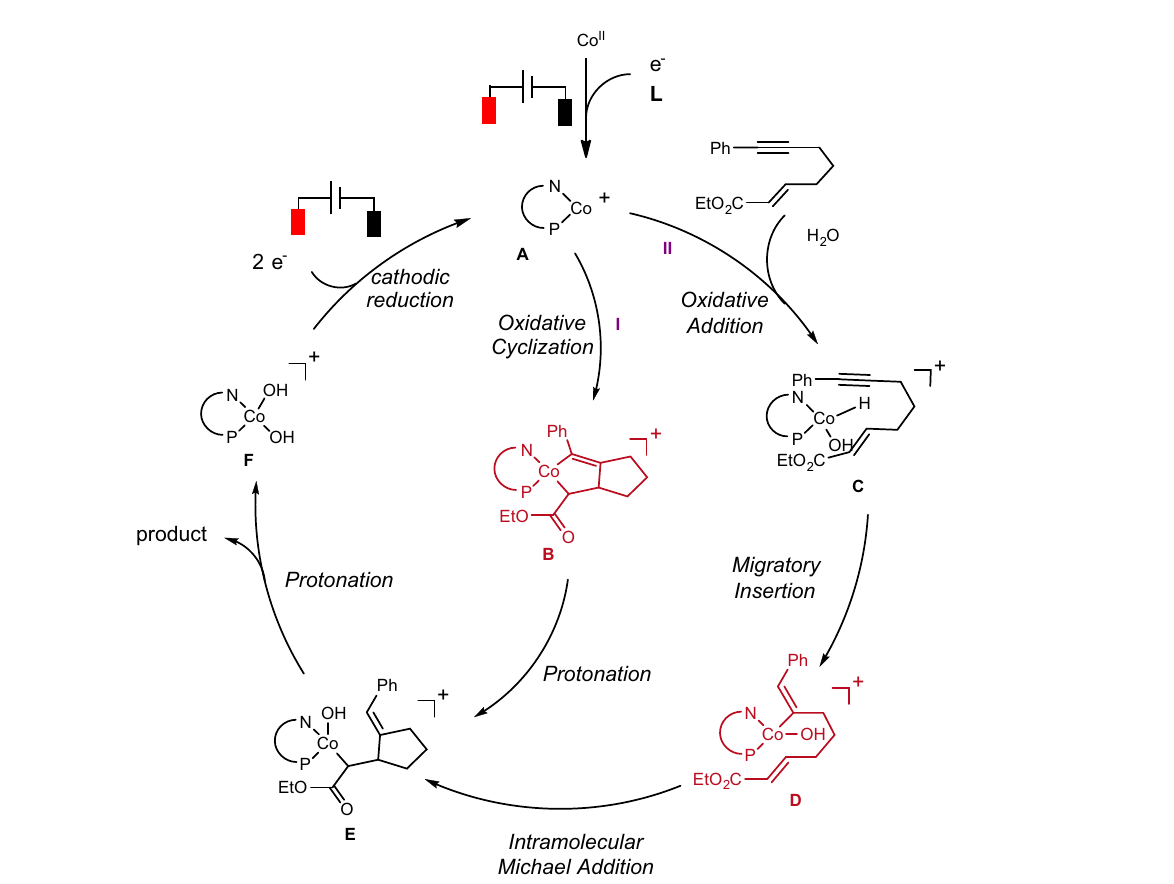
Fig. 3 | Deuterium labelling and control experiments. a Deuterium labelling experiment. b Control experiment on geometry of the alkene.